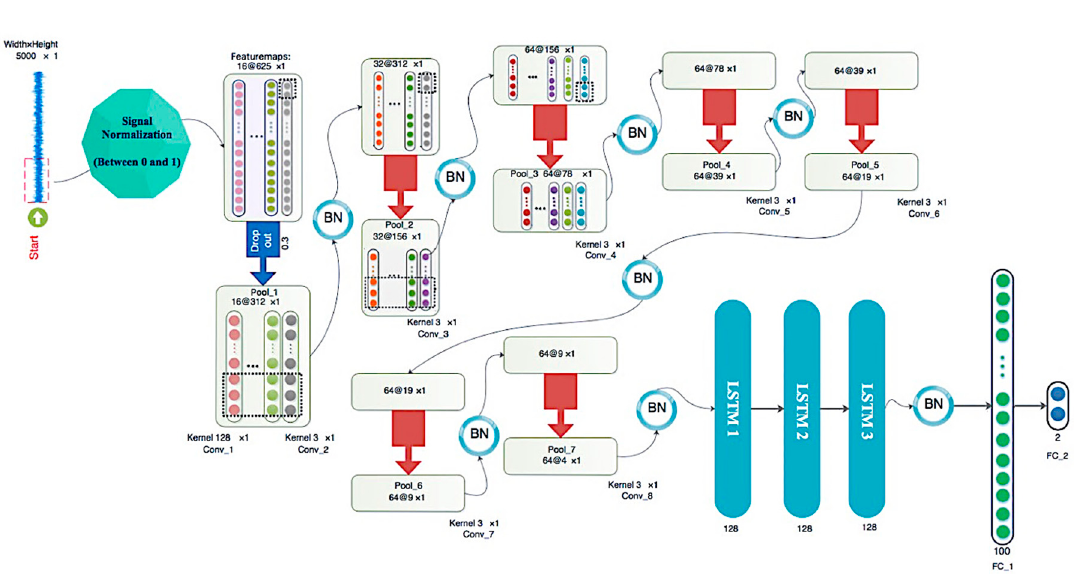
Figure 6. The proposed network architecture.